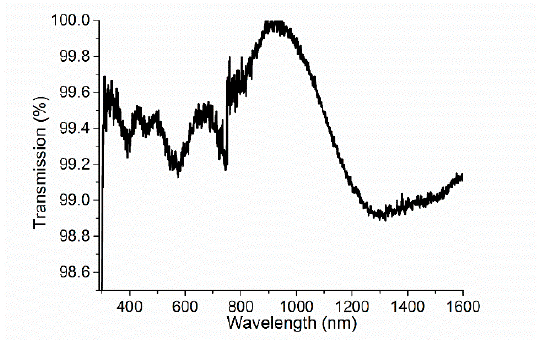
Figure 4. The transmission spectra of silk deposited on a glass substrate (silk #2).